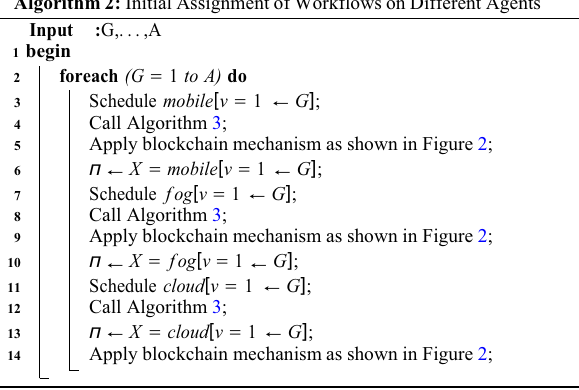
Algorithm 2: Initial Assignment of Workflows on Different